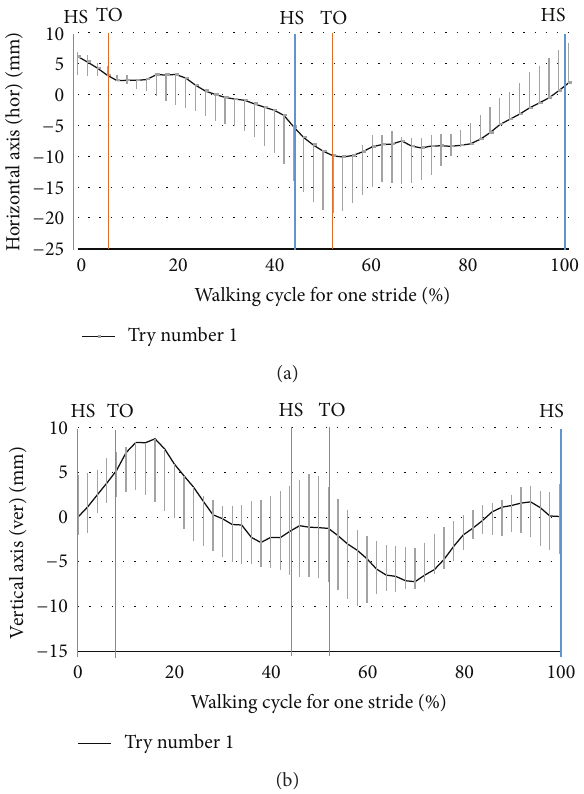
Figure 7: HJC difference between left and right limbs for horizontal axis (a) and vertical (b) axis.